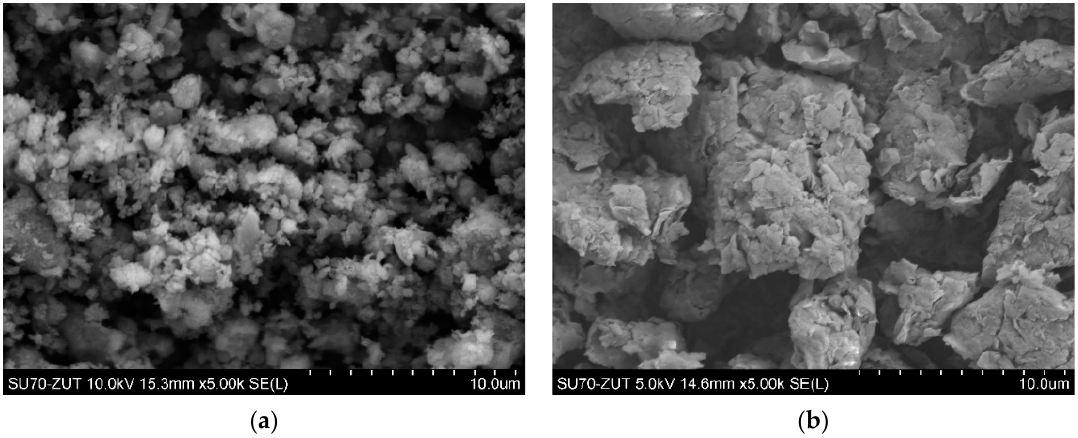
Figure 1. SEM micrographs of the mineral nanofillers as received: ( a ) HNT; ( b ) C20A.